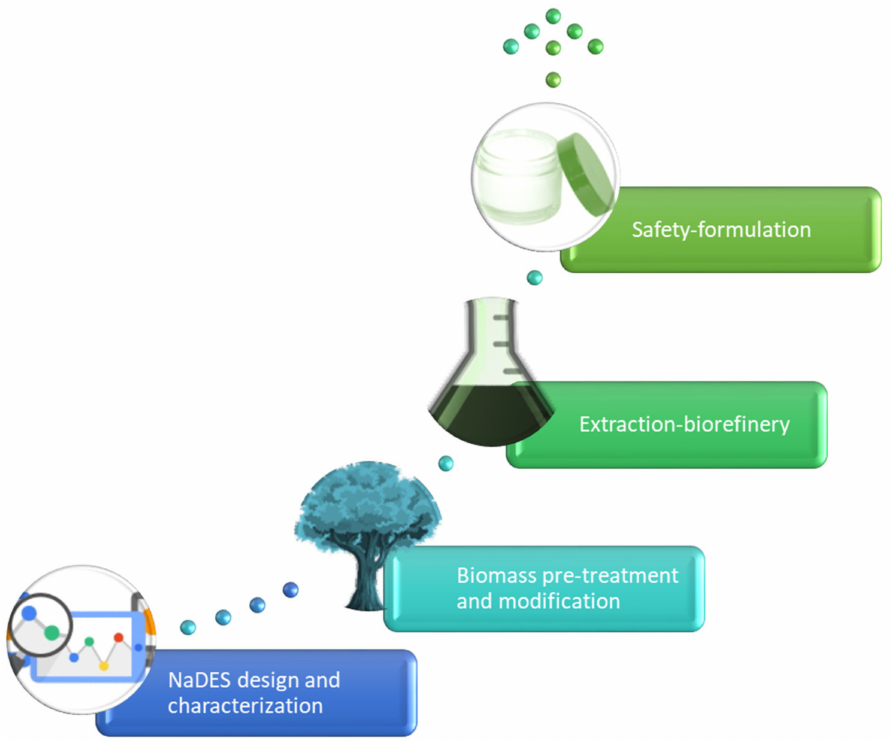
Figure 3. Workflow using NaDES for